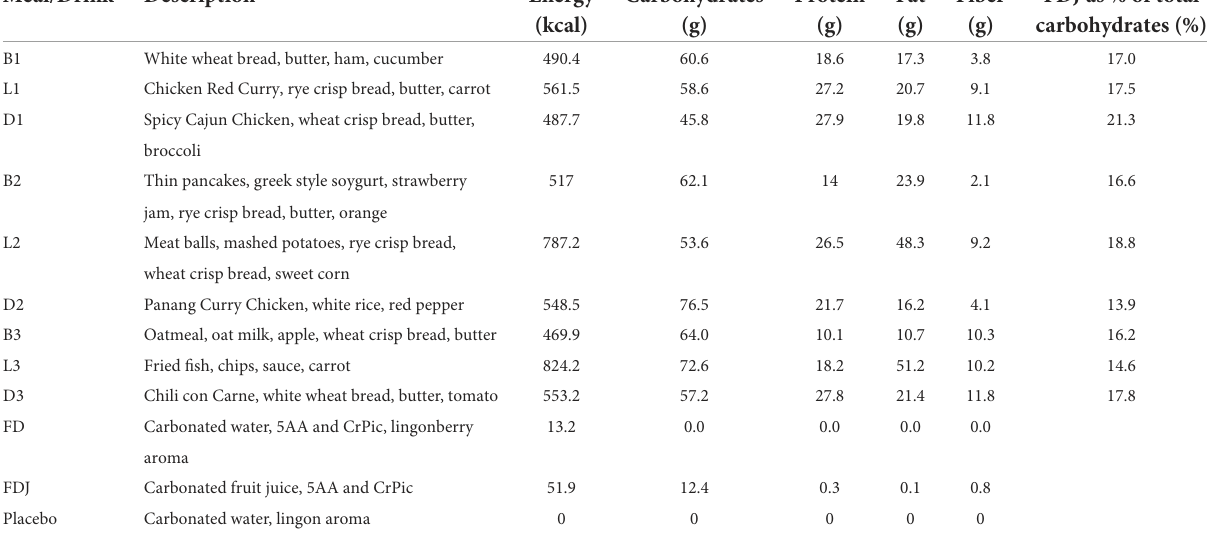
difference in C-max between placebo and FDJ was significant ( p = 0.001), whereas the 6% difference between placebo and FD was borderline significant ( p = 0.053). The ANCOVA model for assessing C-max differed slightly to the model for iAUC 0 − 120min , it did not include total protein and physical activity before and after the meal as covariates, since these were not significant. The included covariates were assessed at following levels: total carbohydrates at 65.3 g and total fats at 25.5 g. When pooling FD and FDJ data and comparing them to placebo, the ANCOVA model remained unchanged with regards to included variables and the C-max difference between drinks was 9% and significant (FD/FDJ: 139.6 mg/dl vs. placebo 152.8 mg/dl, p = 0.001). No significant differences were found for T-Max. No significant differences were found for the change from baseline to peak subcutaneous glucose. Participants were within the physiological target range as defined by the